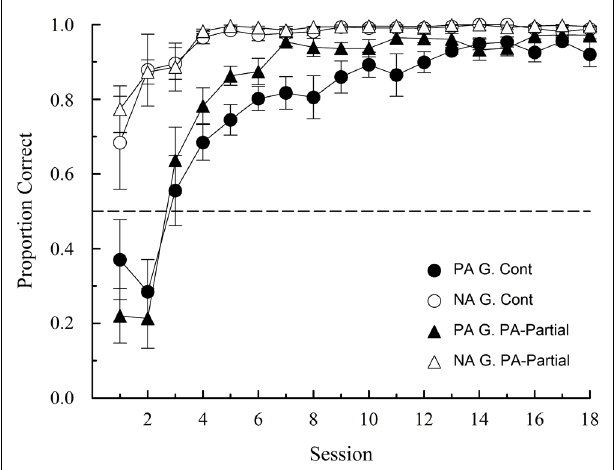
FIGURE 3 | Proportion of correct choices ( ± 1 SEM) on PA and NA trials during acquisition in Experiment 1. G denotes